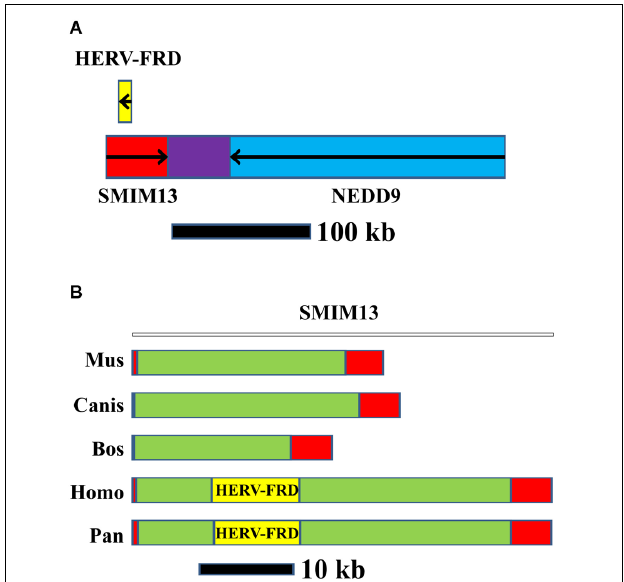
FIGURE 3 | Organization of the NEDD9/SMIM13/HERV-FRD region in humans and other species. (A) HERV-FRD is located in the intron of SMIM13 . SMIM13 and NEDD9 are located tail-to-tail orientated on human chromosome 6. (B) Comparison of the SMIM13/HERV-FRD region in different vertebrate species. Red: exons of SMIM13; green: SMIM13 intron; yellow: HERV-FRD. ( Figure 3 ). HERV-FRD entered the primate genomes more than